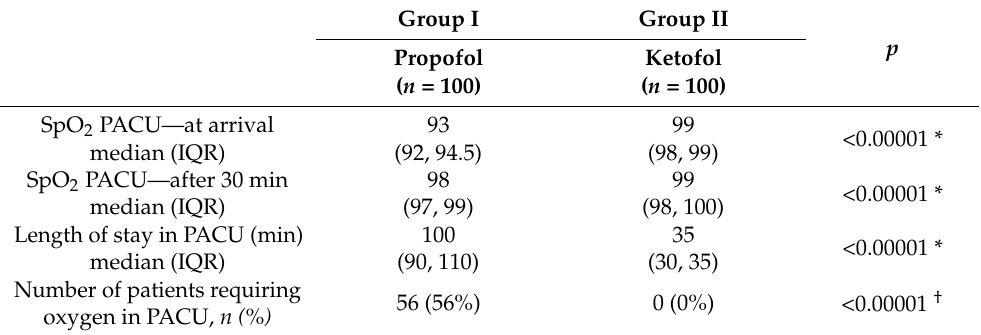
Table 3. Post-anesthesia care unit data of the